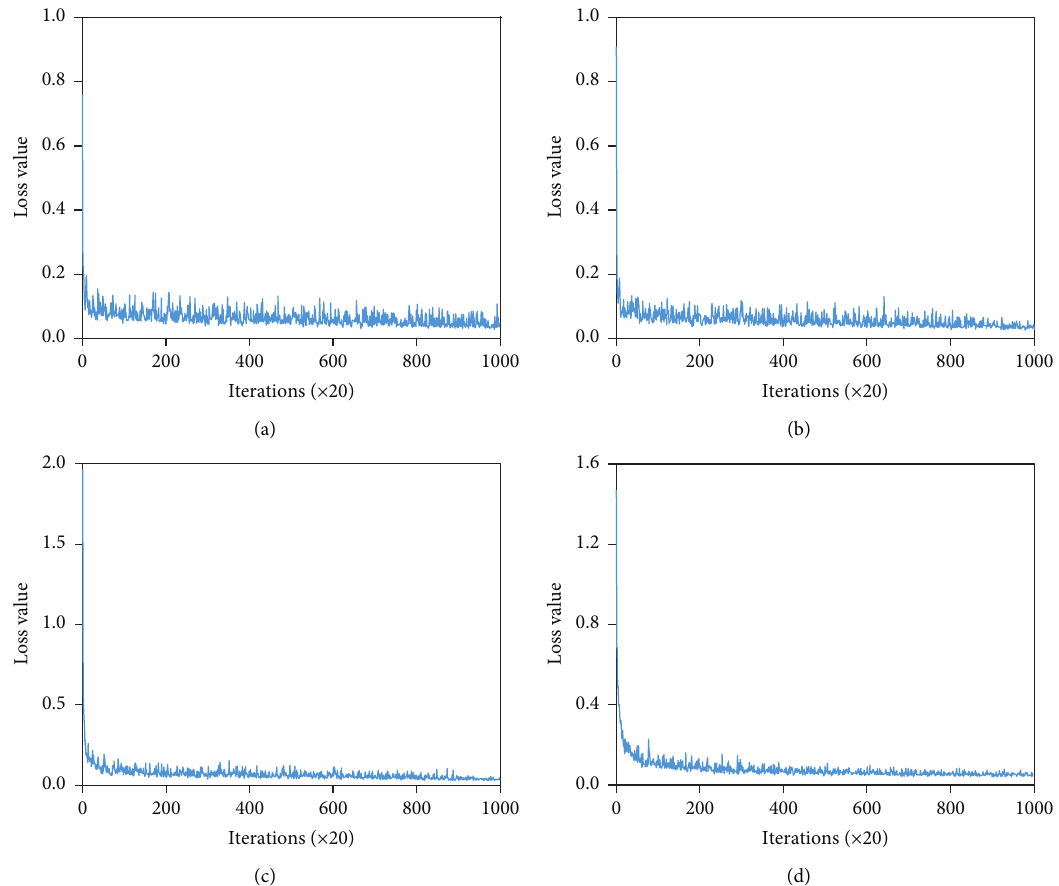
Figure 10: The loss value in the training process of four methods. (a) U-Net loss. (b) DeepLabv3 loss. (c) PSPNet loss. (d)